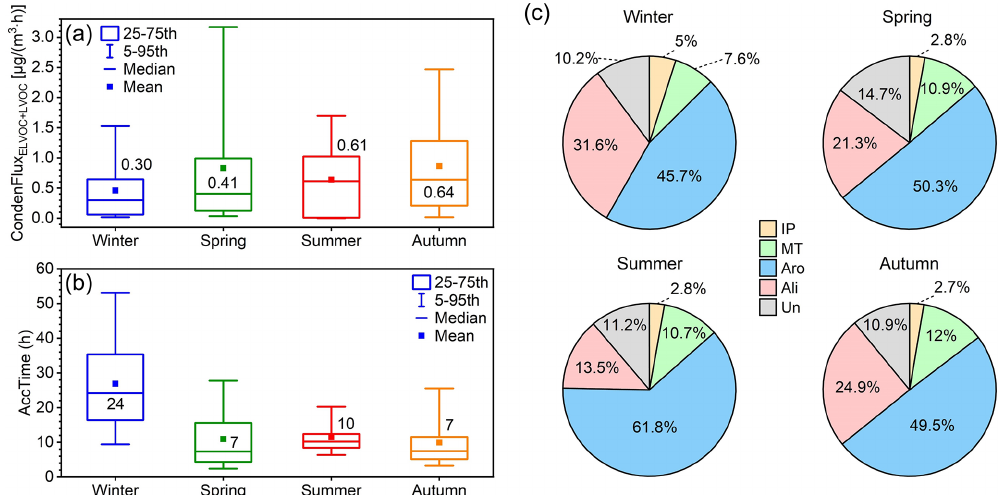
Figure 11. (a) Condensation flux of OOMs calculated by the particle dynamic model by Tröstl et al. (2016) in four seasons. (b) Characteristic accumulation time of SOA (AccTime), calculated as SOA divided by OOM condensation flux, in four seasons. This parameter is used as an indicator of the relative accumulation rate of SOA caused by OOM condensation in different seasons. The values in each box of panels (a) and (b) are the median values of corresponding parameters. (c) Estimated condensation flux contribution of four source-classified OOMs in four seasons. The abbreviations IP, MT, Aro, Ali, and Un stand for IP OOMs, MT OOMs, aromatic OOMs, aliphatic OOMs, and undistinguished OOMs,